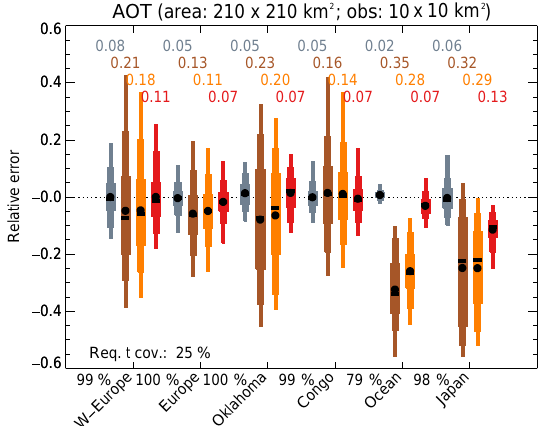
Figure 7. Monthly representation errors after collocation for remote sensing ground sites: purely spatial sampling (grey), no collocation (brown), area data collocated to the day of observations (bright or- ange) and area data collocated to the hour (red). The grey and brown error estimates are similar to Fig. 6, except for a required temporal coverage of 25%. Further explanation in Sect.